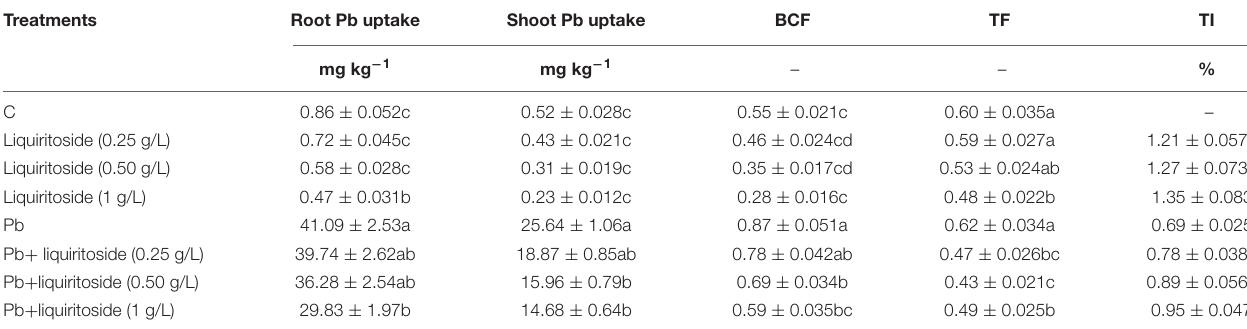
Values presented are mean ± standard error of two independent experiments. Data marked by the different letters in the same column are significantly different at p < 0.05, C = Control, Pb = Lead (75 mg/kg